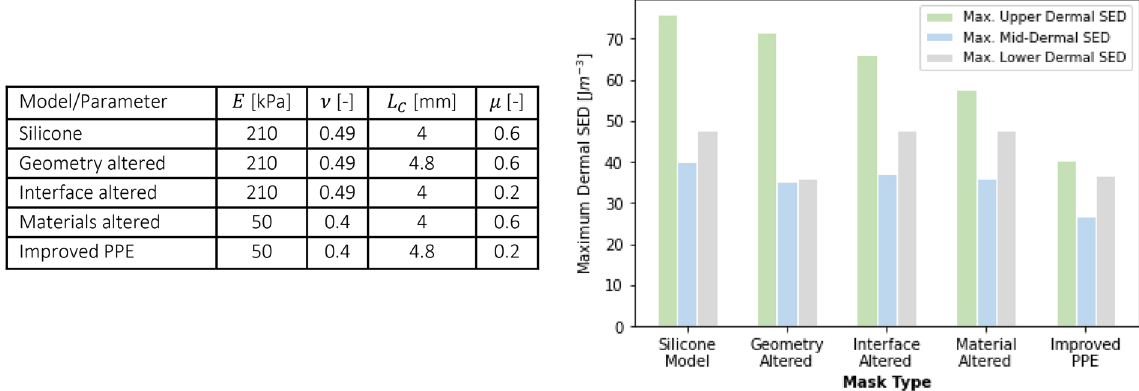
Figure 4. Table (left) showing different mask modifications compared to a silicone-based model. Graph (right) showing the SED in the upper (green), middle (blue) and lower dermis (grey) in response to the